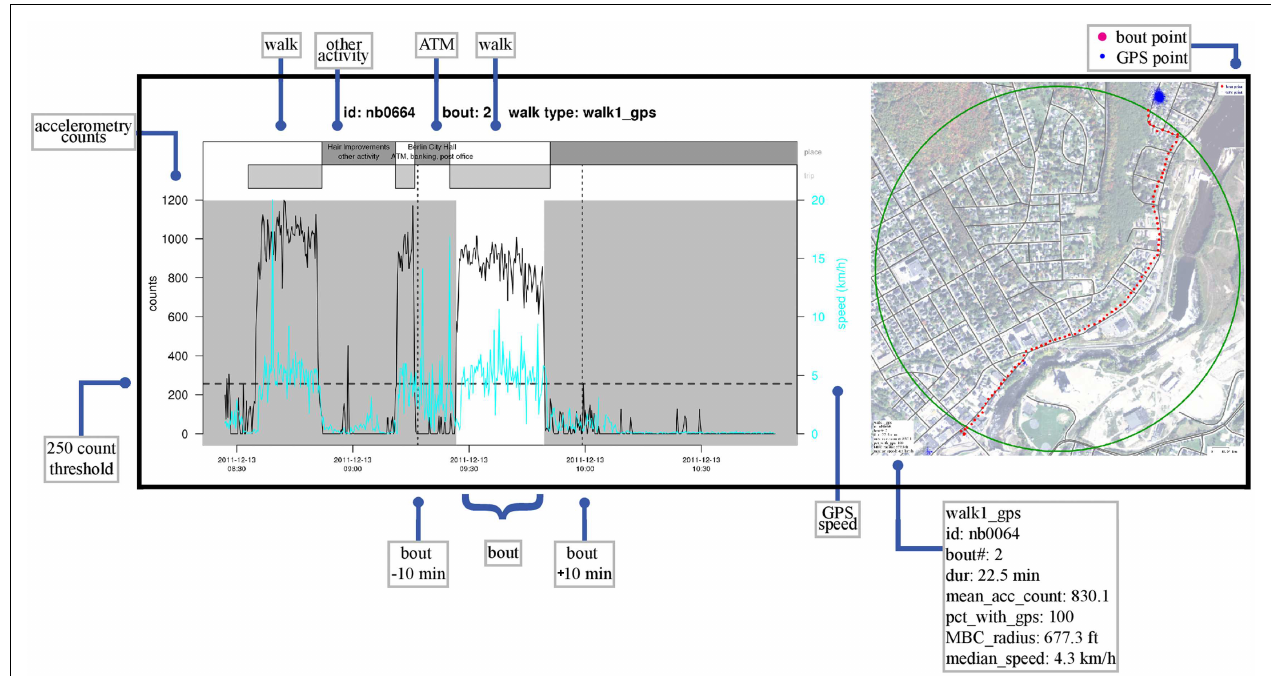
indicates the accelerometry threshold used to define a bout of walking.The dashed vertical lines are at 10min on either side of the bout. Right panel: map of bout location. Larger red dots are individual GPS locations for the bout, with all GPS locations shown as small blue dots.The green circle indicates the boundary for the 95% most tightly clustered points in the